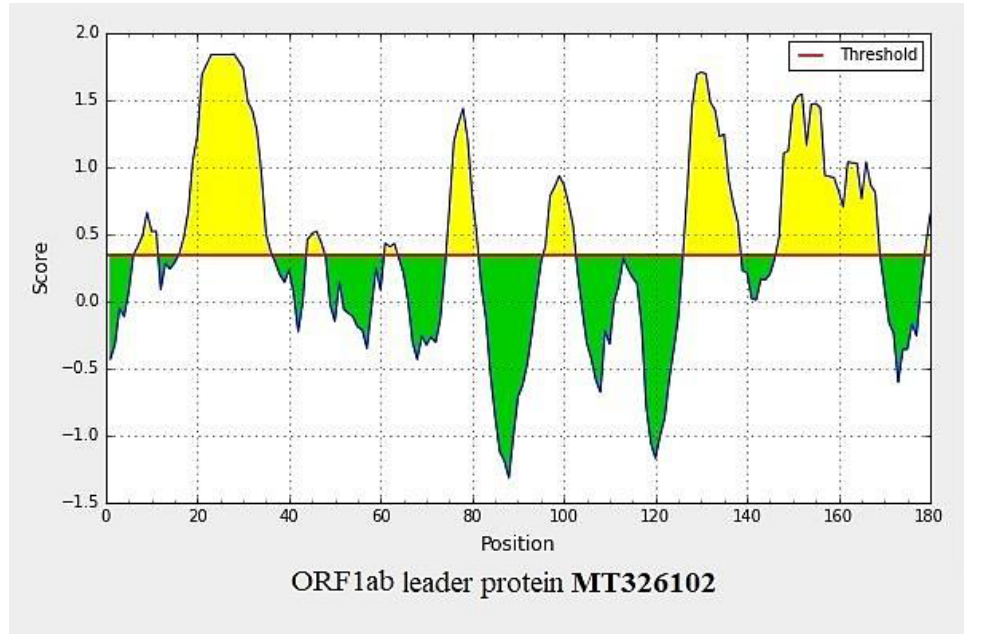
Figure 1. B-cell epitope prediction of the ORF1ab leader protein MT326102